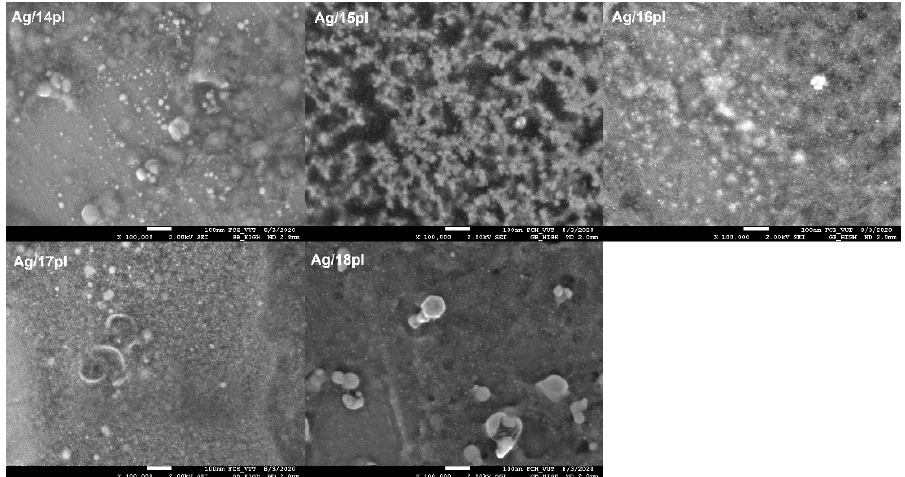
Figure 5. SEM images of AgNPs stabilized with phospholium surfactants.